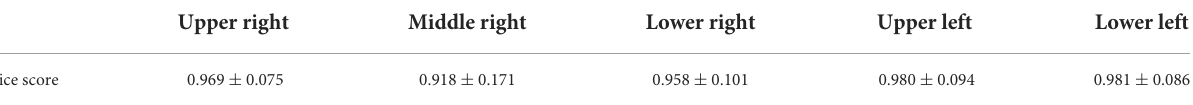
TABLE 3 Average Dice score of the lobe segmentation model on 21 CT scans. Upper